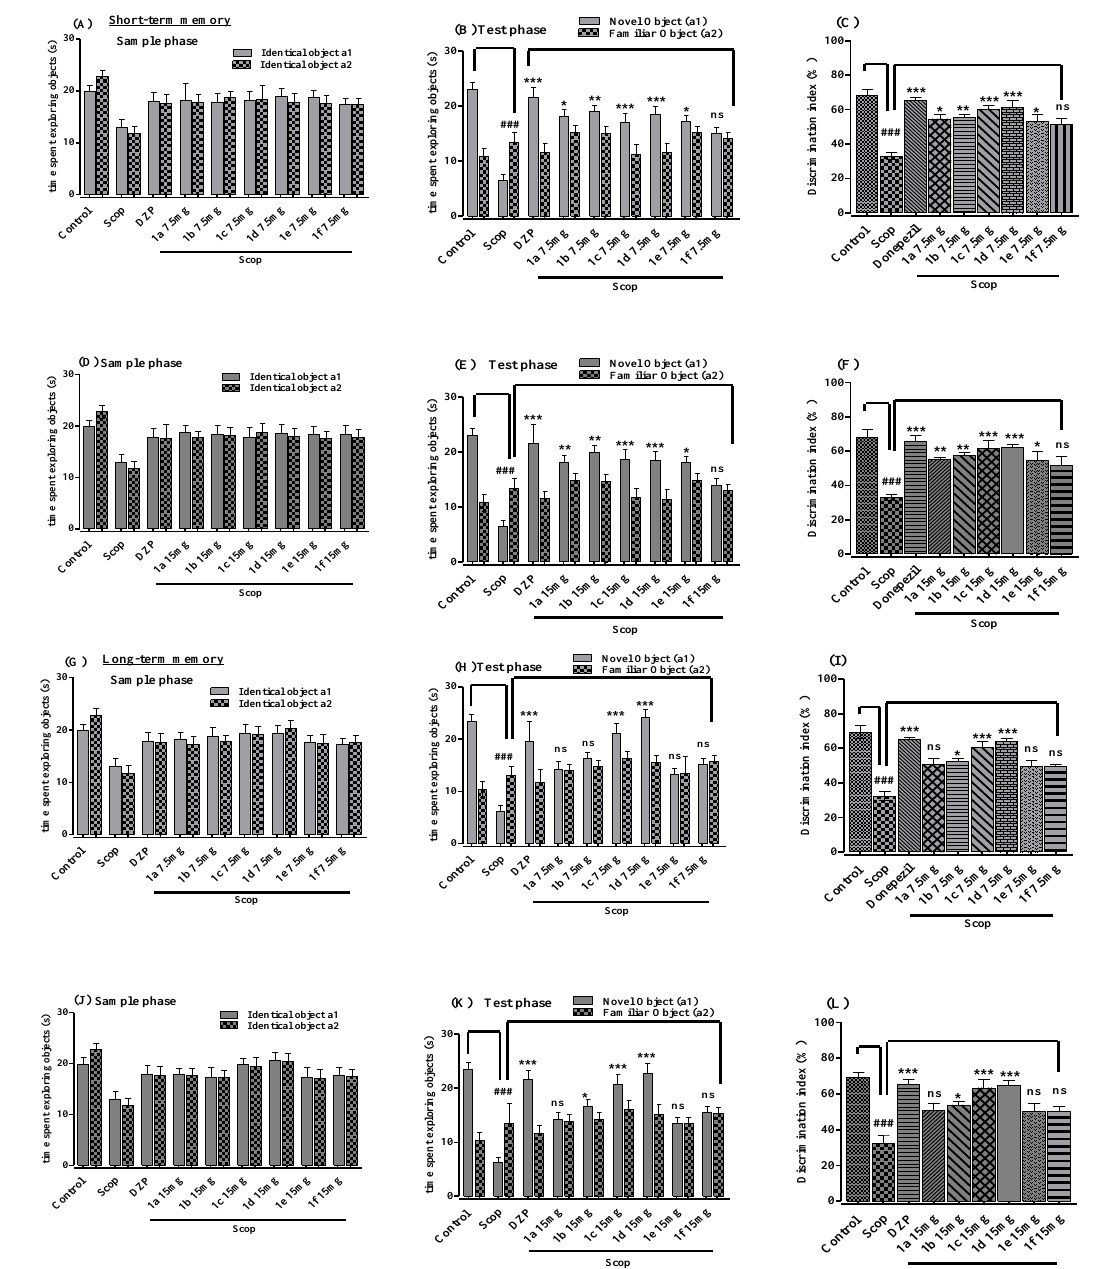
Figure 4. The effect of synthesized curcumin analogs for the evaluation of memory ( 1a–1f ) in NORT ( A ) Time spent in the sample phase, ( B ) Time spent in the test phase, ( C ) Discrimination index (%) were measured in treated groups (7.5 mg/kg) versus scopolamine (1 mg/kg) treated group. ( D ) Time spent in the sample phase, ( E ) Time spent in the test phase, ( F ) Discrimination index (%) were measured in treated groups (15 mg/kg) versus scopolamine (1 mg/kg) treated group for measuring short-term memory in NORT behavioral mice model; ( G ) Time spent in the sample phase, ( H ) Time spent in the test phase, ( I ) Discrimination index (%) were measured in treated groups (7.5 mg/kg) versus scopolamine (1 mg/kg) treated group. ( J ) Time spent in the sample phase, ( K ) Time spent in the test phase, ( L ) Discrimination index (%) were measured in treated groups (15 mg/kg) versus scopolamine (1 mg/kg) treated group for measuring long-term memory in NORT behavioral mice model. Results were presented in (mean ± SEM), n = 6. ###P ˂ 0.001 vs. normal control. Significantly different values were compared with amnesic group; ***, **, * and ‘ns represents p -value ˂ 0.001, ˂ 0.01, ˂ 0.05, ˃ 0.05 respectively.